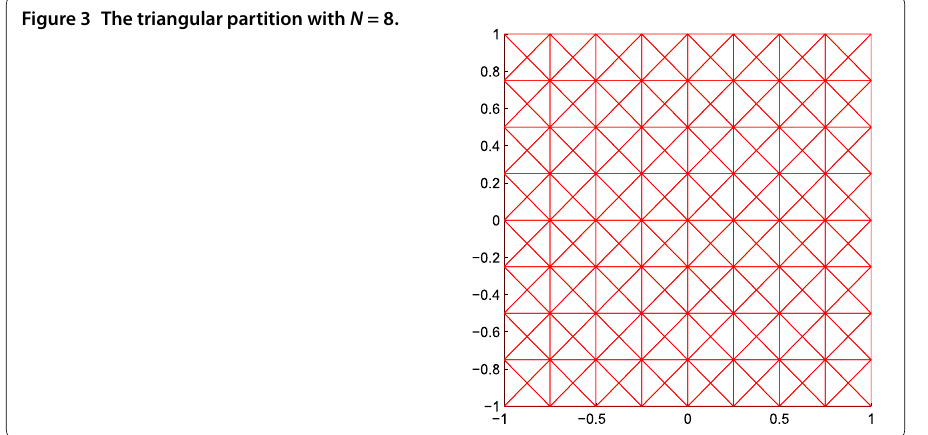
Figure 3 The triangular partition with N =